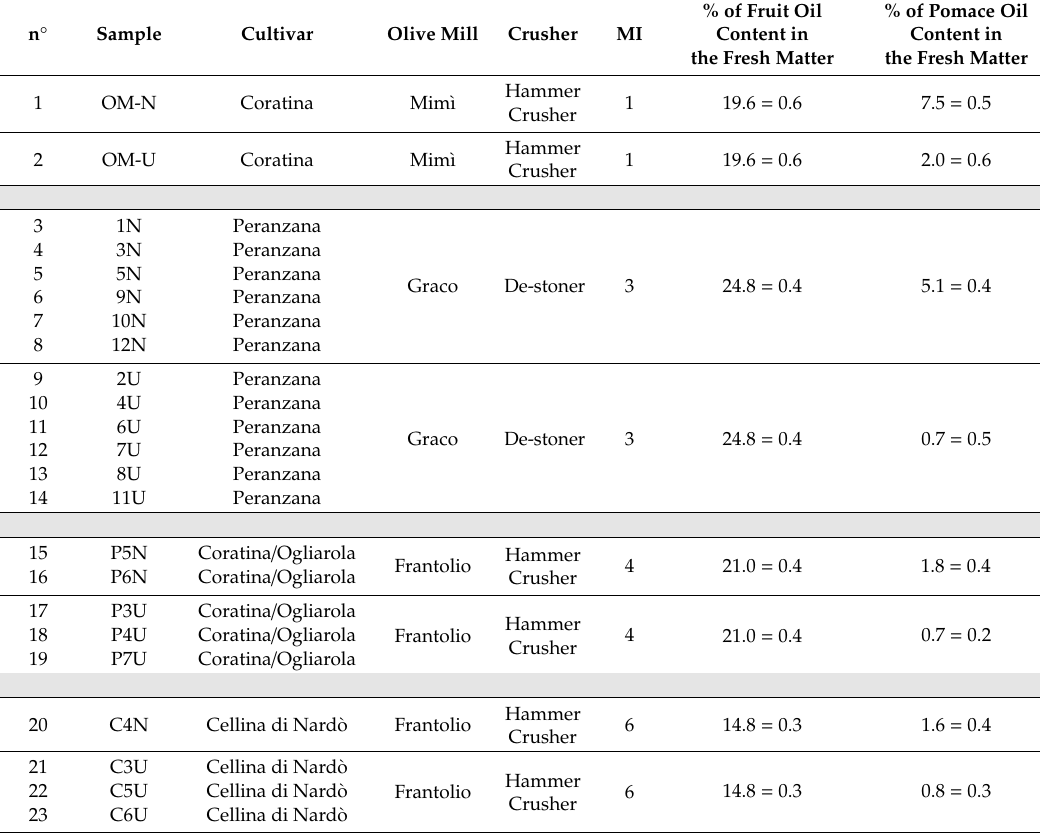
Table 2. Maturity index (MI) classification groups of olives based on skin and flesh color.